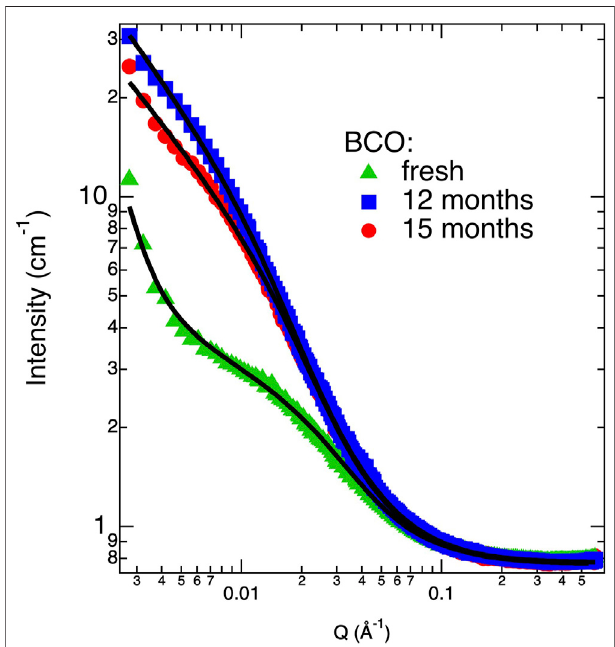
FIGURE 1 | Scattering intensity pro fi les (markers) and correspondent best fi ts (lines) according to Eq. 6 for some of investigated BCO samples.